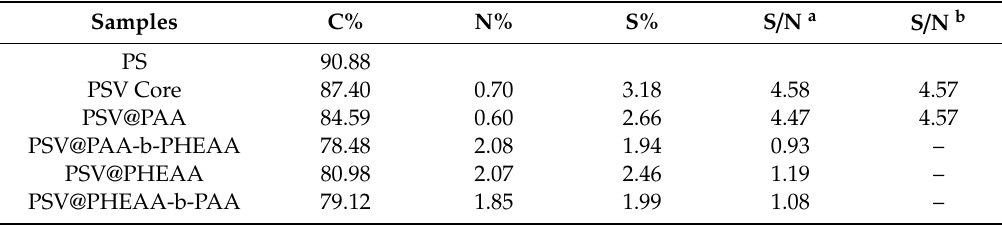
Table 1. Elemental analysis of diblock polymer brushes.